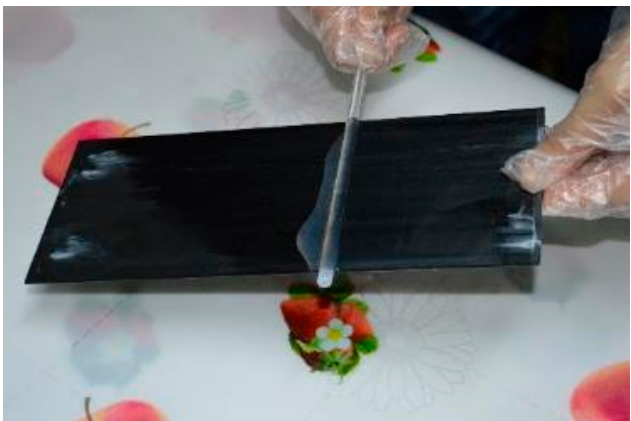
Figure 1. Coating CFRP plate.